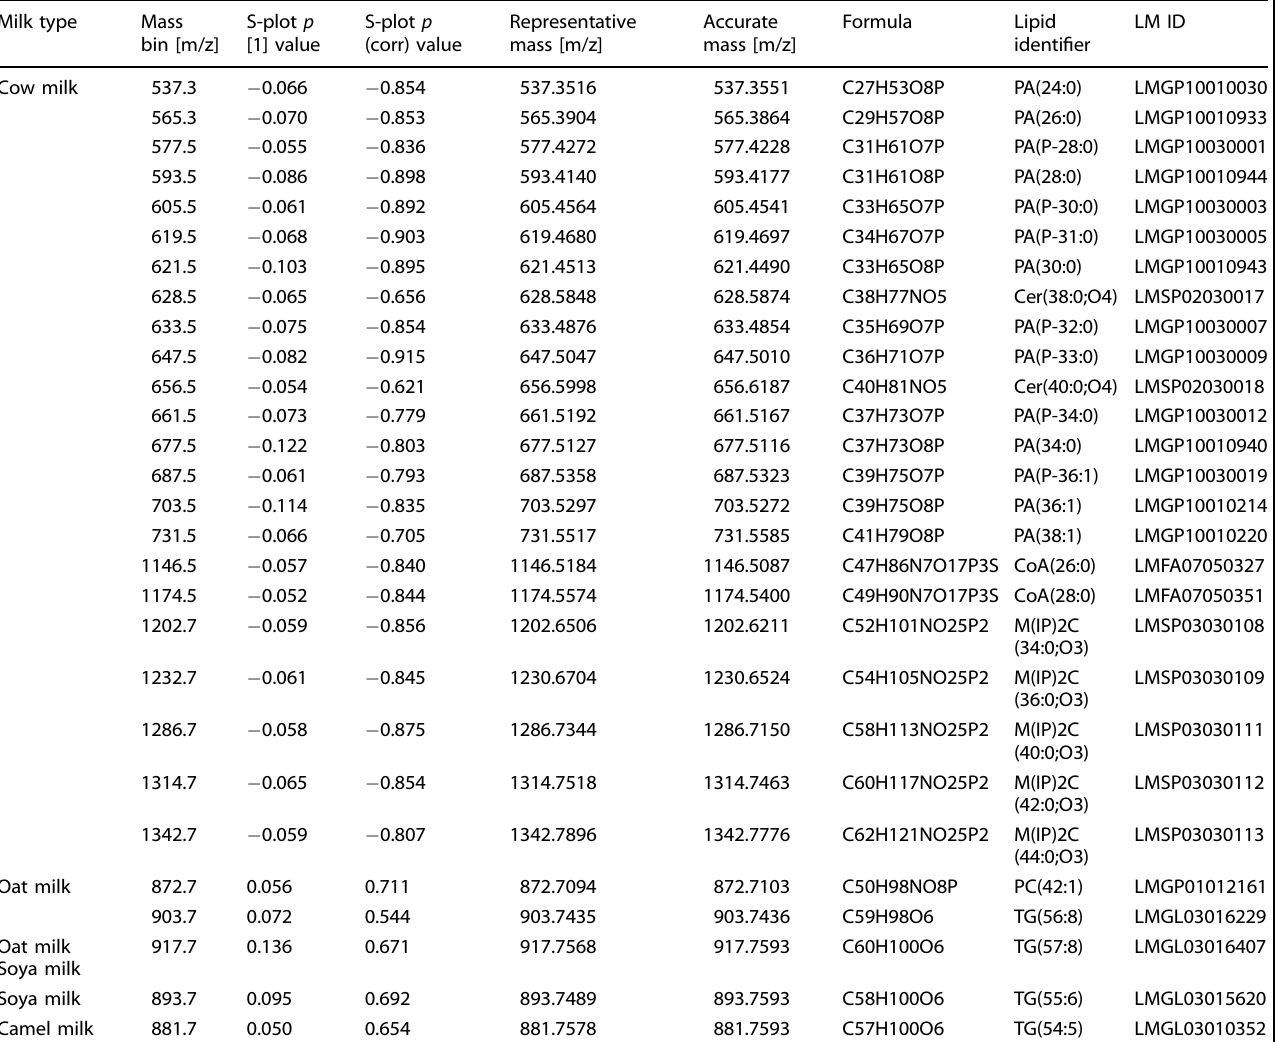
Table 1. List of ions identi fi ed based on the contribution of each ion to the variance of the observations and their reliability. Milk type Mass bin